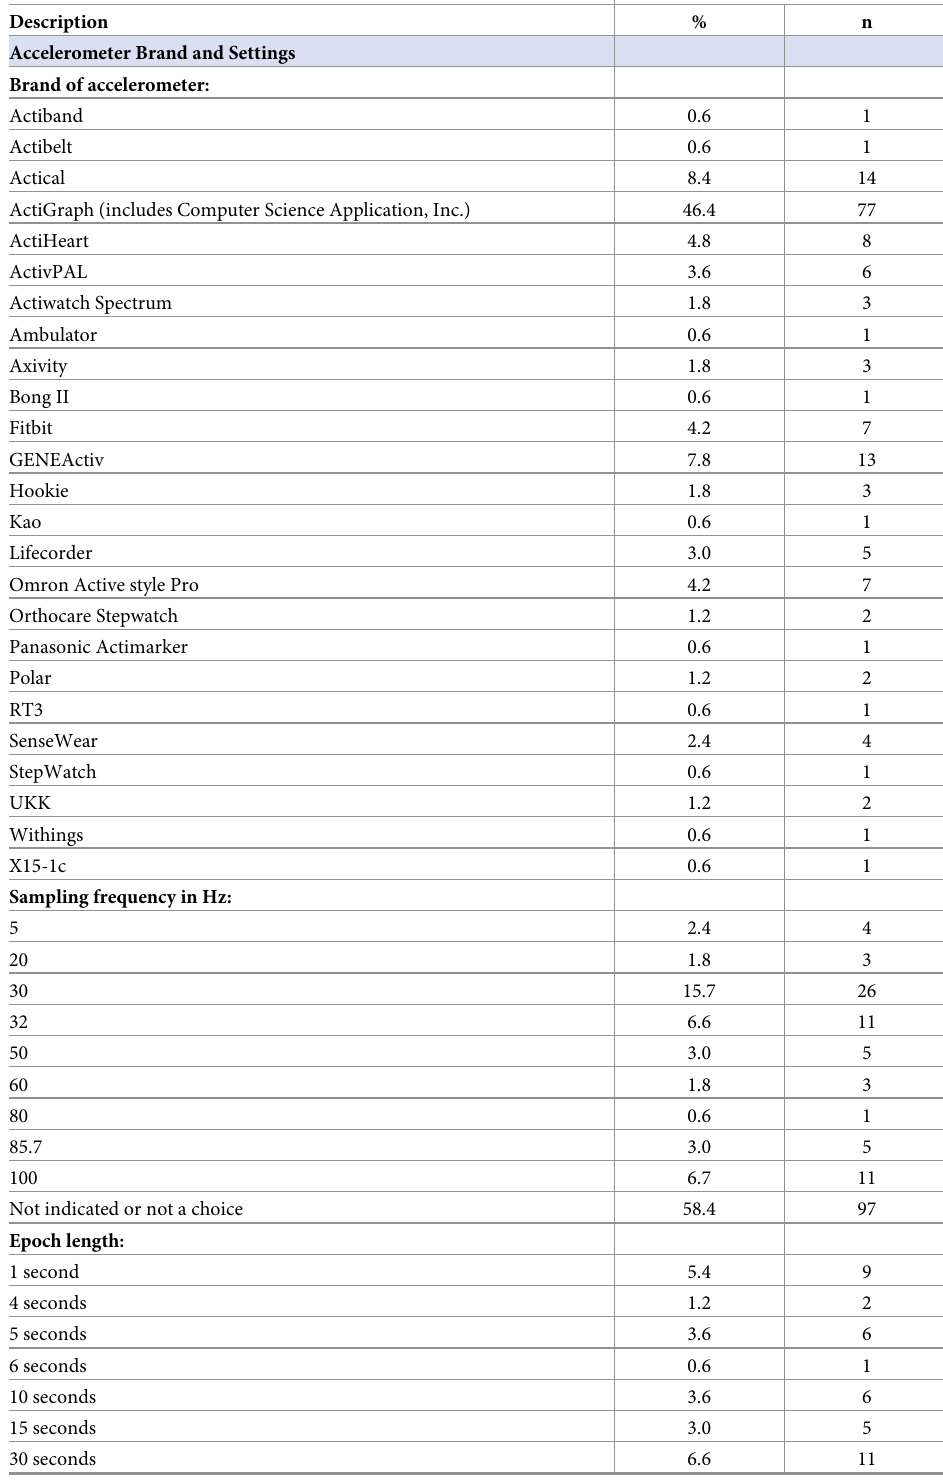
Table 2. Description of accelerometers used by observational studies of adults (n =